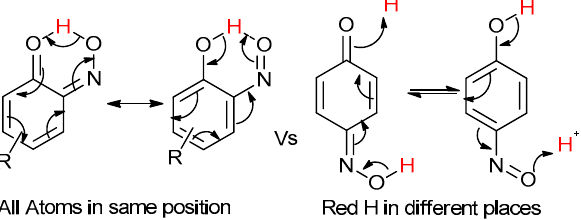
Figure 4. The consideration that the quinone and nitroso structures may be related by resonance if the nitroso is ortho to the phenol. Otherwise, a hydrogen atom is in a different position depending on the tautomer.